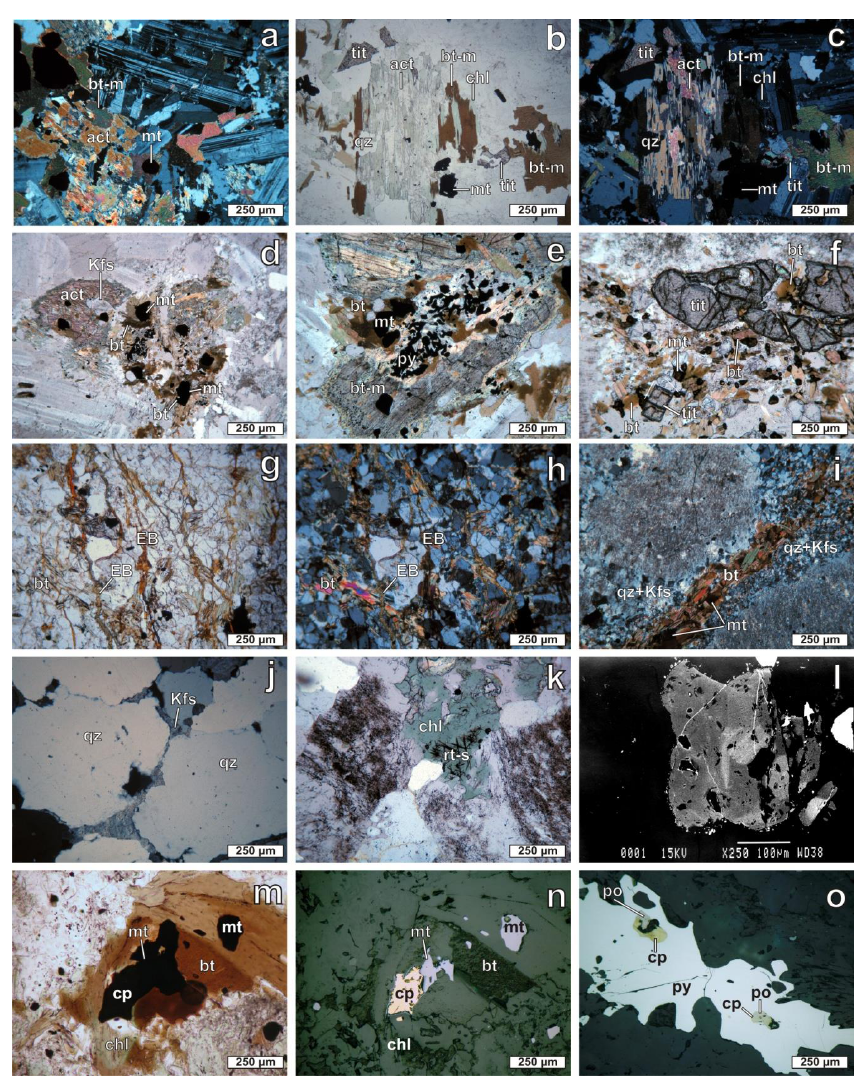
Figure 5. Photomicrographs of textures and minerals of the potassic and sodic-calcic alteration in the Maronia porphyry type mineralization. Plane polarized light: a, e, g, h, i, k, m; crossed-polarized light: b,c,d,f,j; plane reflected light images: n, o; SEM back-scattered image: l. ( a ) Magmatic biotite (bt-m) replaced by hydrothermal actinolite (act) and magnetite (mt) of the sodic-calcic alteration in the monzonite; ( b , c ) Magmatic biotite (bt-m) altered to hydrothermal actinolite (act), titanite (tit), chlorite (chl) and magnetite (mt) of the sodic-calcic alteration in the sheared monzonite; ( d ) Euhedral magmatic amphibole selectively altered to hydrothermal biotite (bt) and magnetite (mt). Primary K-feldspar (Kfs) is also present. Potassic alteration in the monzonite; ( e ) Magmatic biotite (bt-m) altered to hydrothermal biotite (bt), K-feldspar (Kfs), magnetite (mt) and pyrite (py) of the potassic alteration in the monzonite; ( f ) Hydrothermal titanite (tit), biotite (bt) and magnetite (mt) of the potassic alteration in the sheared monzonite; ( g , h ) EB-type veins (EB) and hydrothermal biotite (bt) of the potassic alteration in the microgranite porphyry; ( i ) Hydrothermal biotite (bt) and magnetite (mt) in EB-vein enveloped with a quartz-orthoclase (qz + Kfs) halo of the potassic alteration in the microgranite porphyry; ( j ) Hydrothermal orthoclase (Kfs) around granular quartz (qz) from the potassic alteration in microgranite porphyry; ( k ) Needle-like sagenitic rutile (rt-s) in chlorite (chl), which has totally replaced precursor magmatic biotite in potassic altered microgranite; ( l ) Rutile grain in potassic altered microgranite, showing sector zoning due to heterogeneous chemical composition. Brighter areas represent sectors with higher SrO contents (1.81–3.63 wt. %); ( m , n ) Chalcopyrite (cp) and magnetite (mt) associated with secondary biotite (bt) which is replaced by chlorite (chl), in potassic altered microgranite; ( o ) Chalcopyrite (cp) and pyrrhotite (po) inclusions in pyrite (py) as part of the potassic alteration mineral assemblage, in